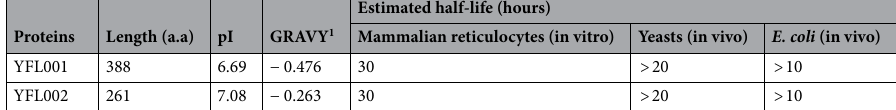
Proteins Length (a.a)